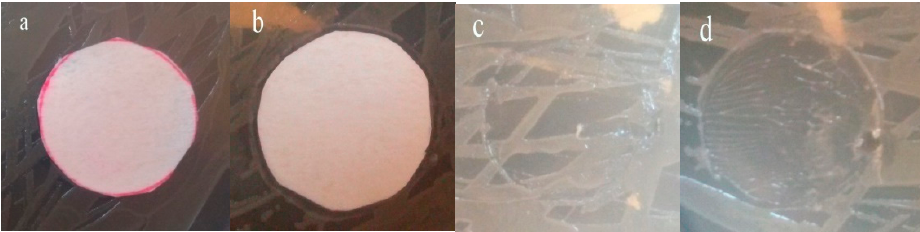
Figure 8. Bacterial growth around ( a ) neat ( b ) and GO/Pt membranes, and ( c , d ) under the membranes after a day, respectively.